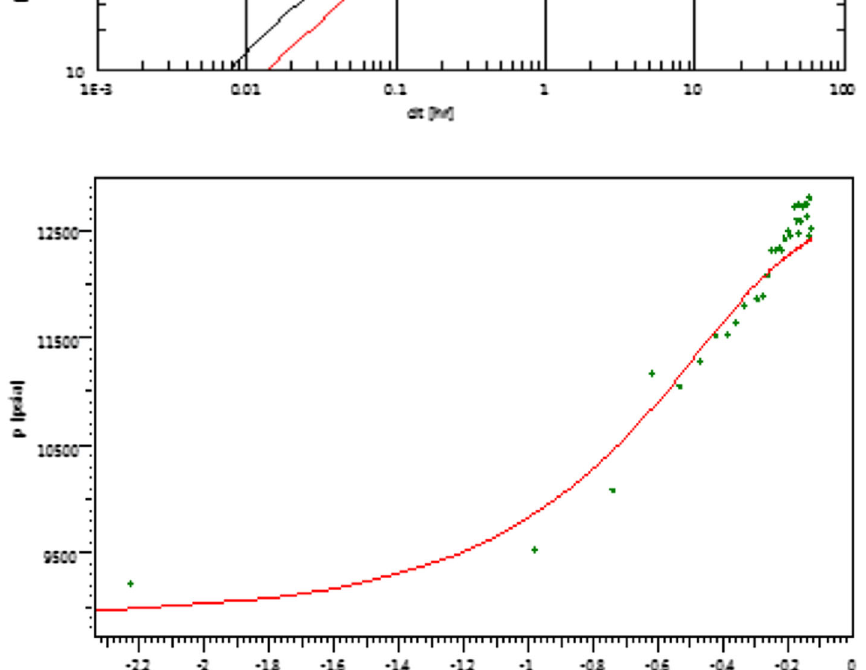
Fig. 4 Simulated